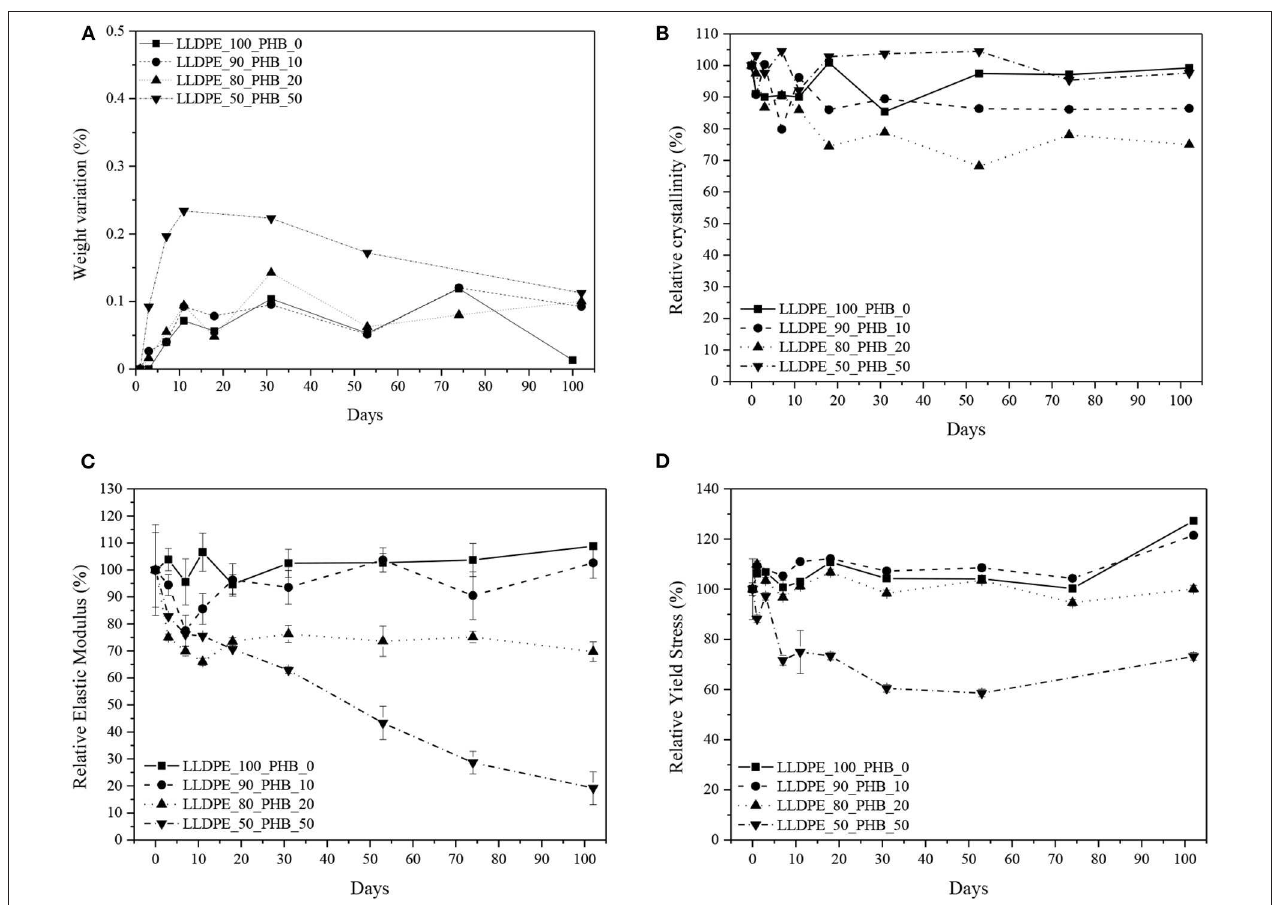
FIGURE 8 | Results of hydrolytic degradation tests on neat LLDPE and relative LLDPE/P(3HB) blends. (A) Weight variation, (B) relative crystallinity degree of LLDPE, (C) relative elastic modulus, (D) relative yield stress. Error bars represent the standard deviation.